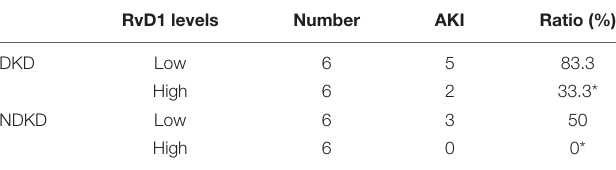
TABLE 4 | Incidence of AKI after surgery.